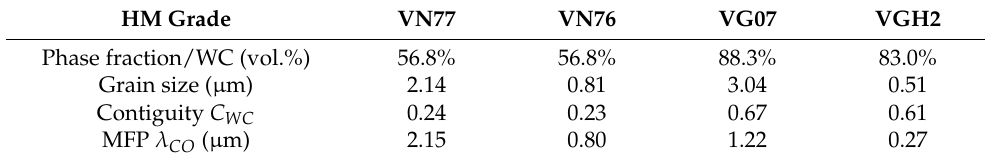
Table 4. Nominal values of the four properties used as references for the assessment. HM Grade VN77 VN76 VG07 VGH2 Phase fraction/WC (vol.%) 56.8% 56.8% 88.3% 83.0% Grain size ( µ m) 2.14 Contiguity C